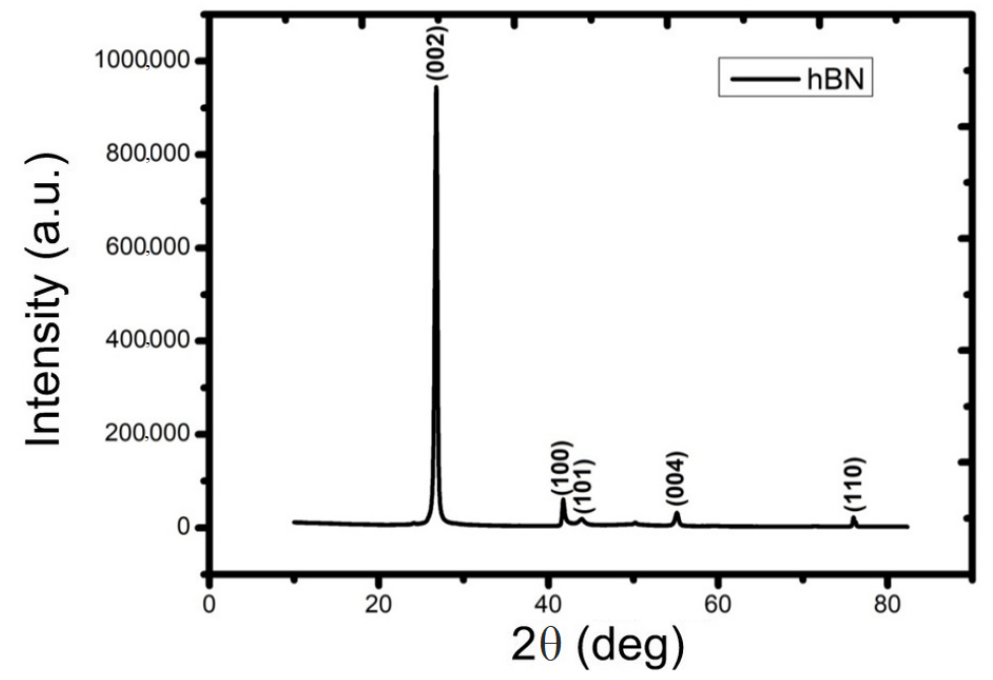
Figure 1. XRD pattern of hBN-NPs.